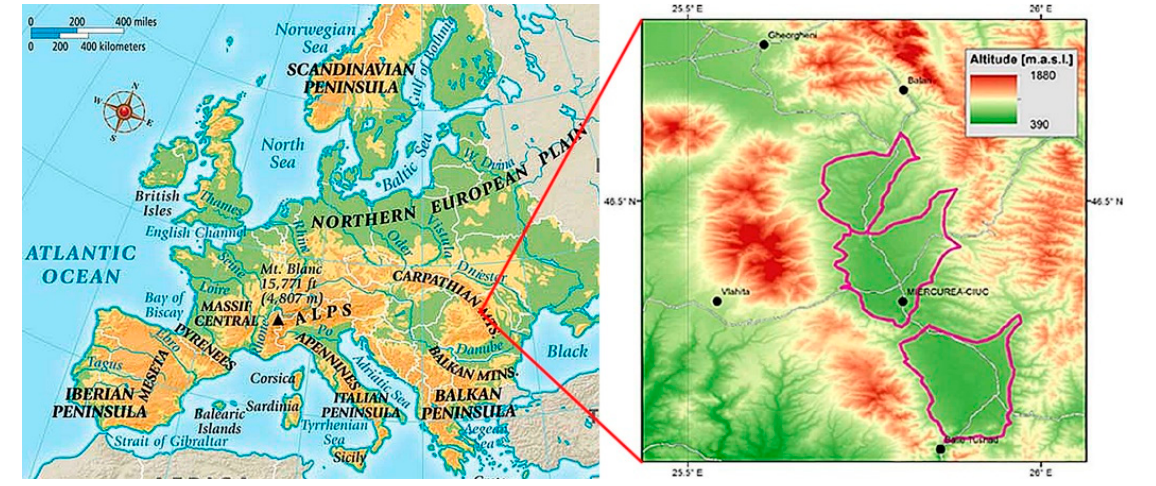
Figure 1. Sampling site location. The main parts of the Ciuc basin are marked with red lines.